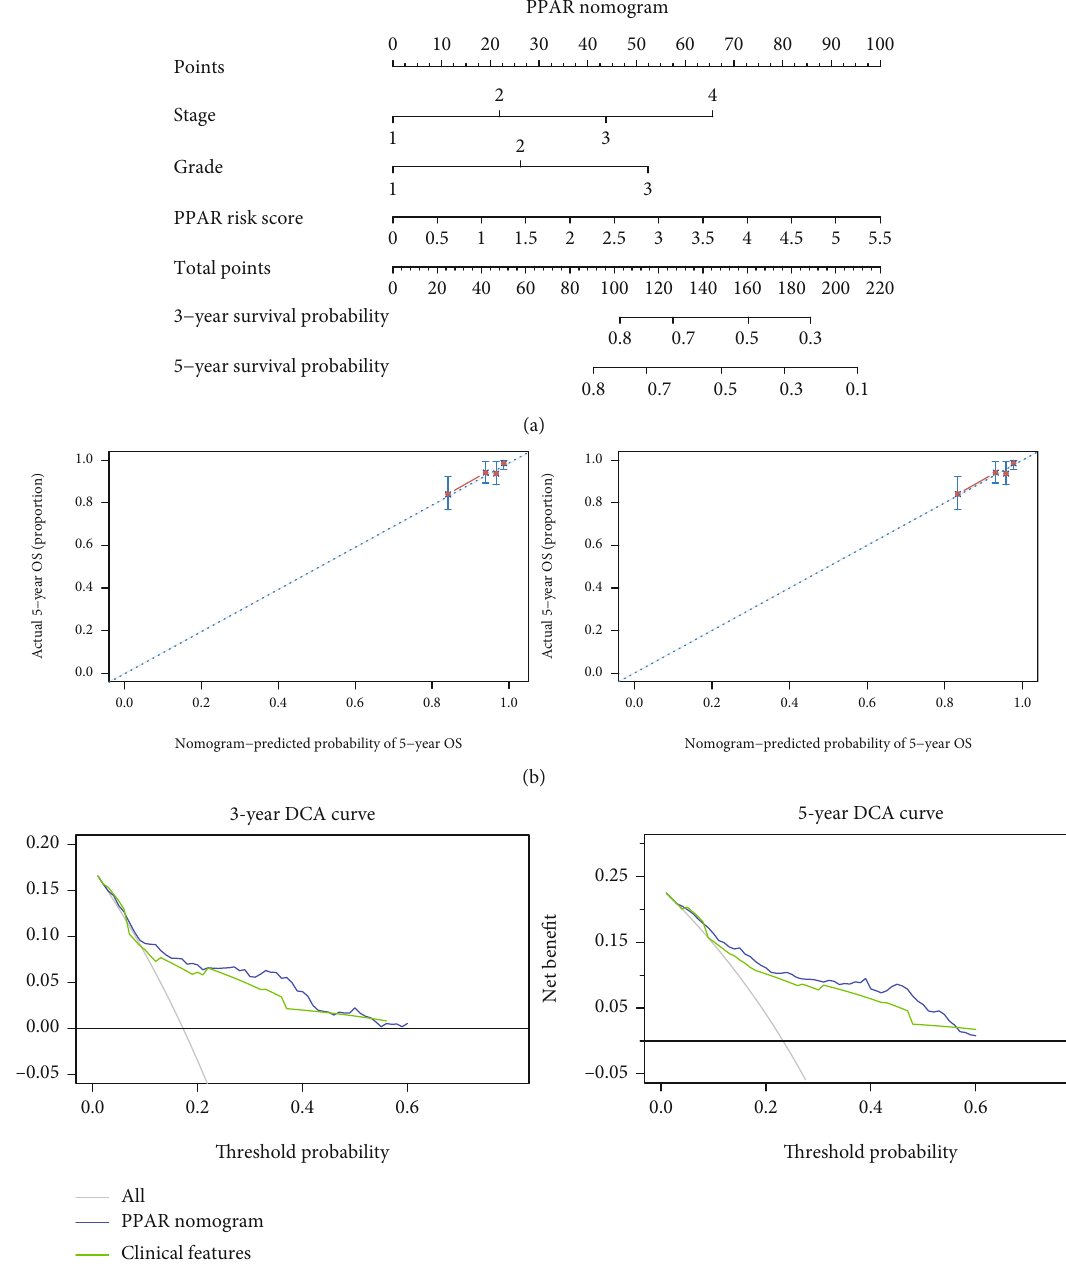
Figure 8: The establishment and veri fi cation of a nomogram based on the PPAR risk score . (a) A nomogram for estimating individual UCEC patients ’ 3- and 5-year survival chances. (b) Plots show how the nomogram was calibrated using the PPAR risk score in terms of consistency between anticipated and observed 3- and 5-year outcomes. (c) Nomogram decision curve studies for 3- and 5-year